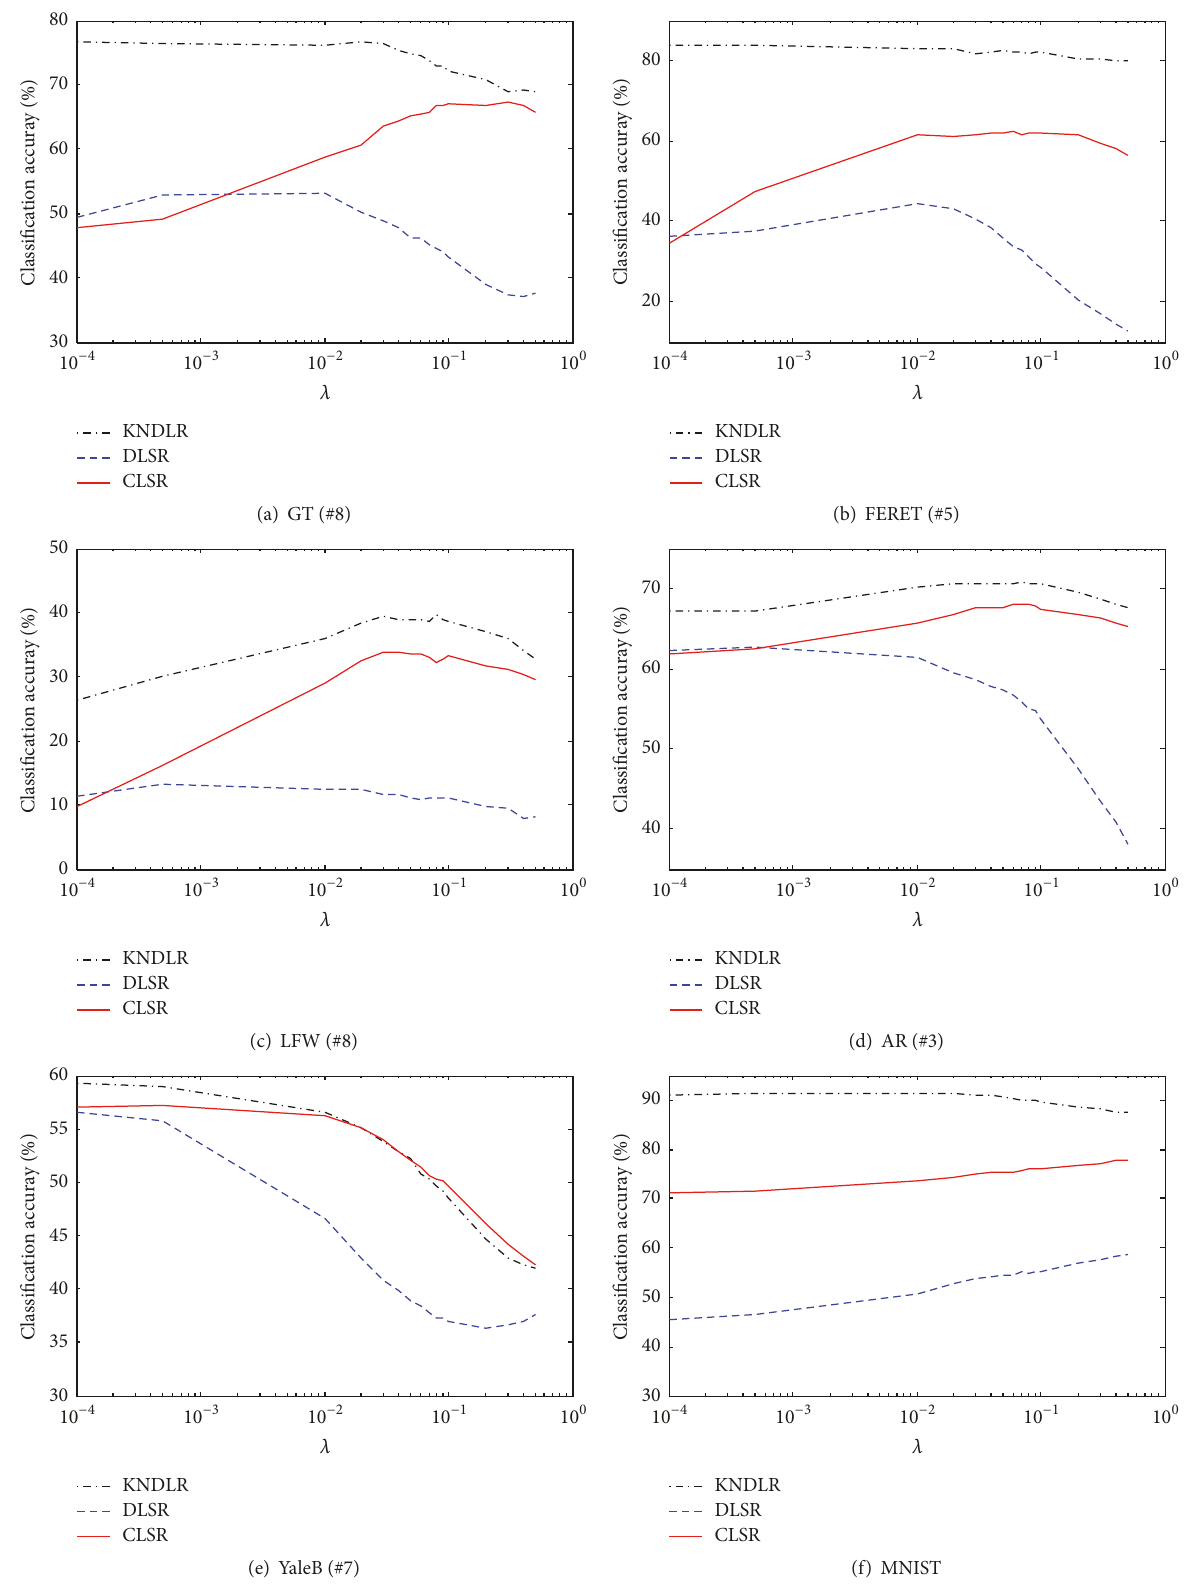
Figure 7: The classification accuracies (%) versus value 𝜆 on the six